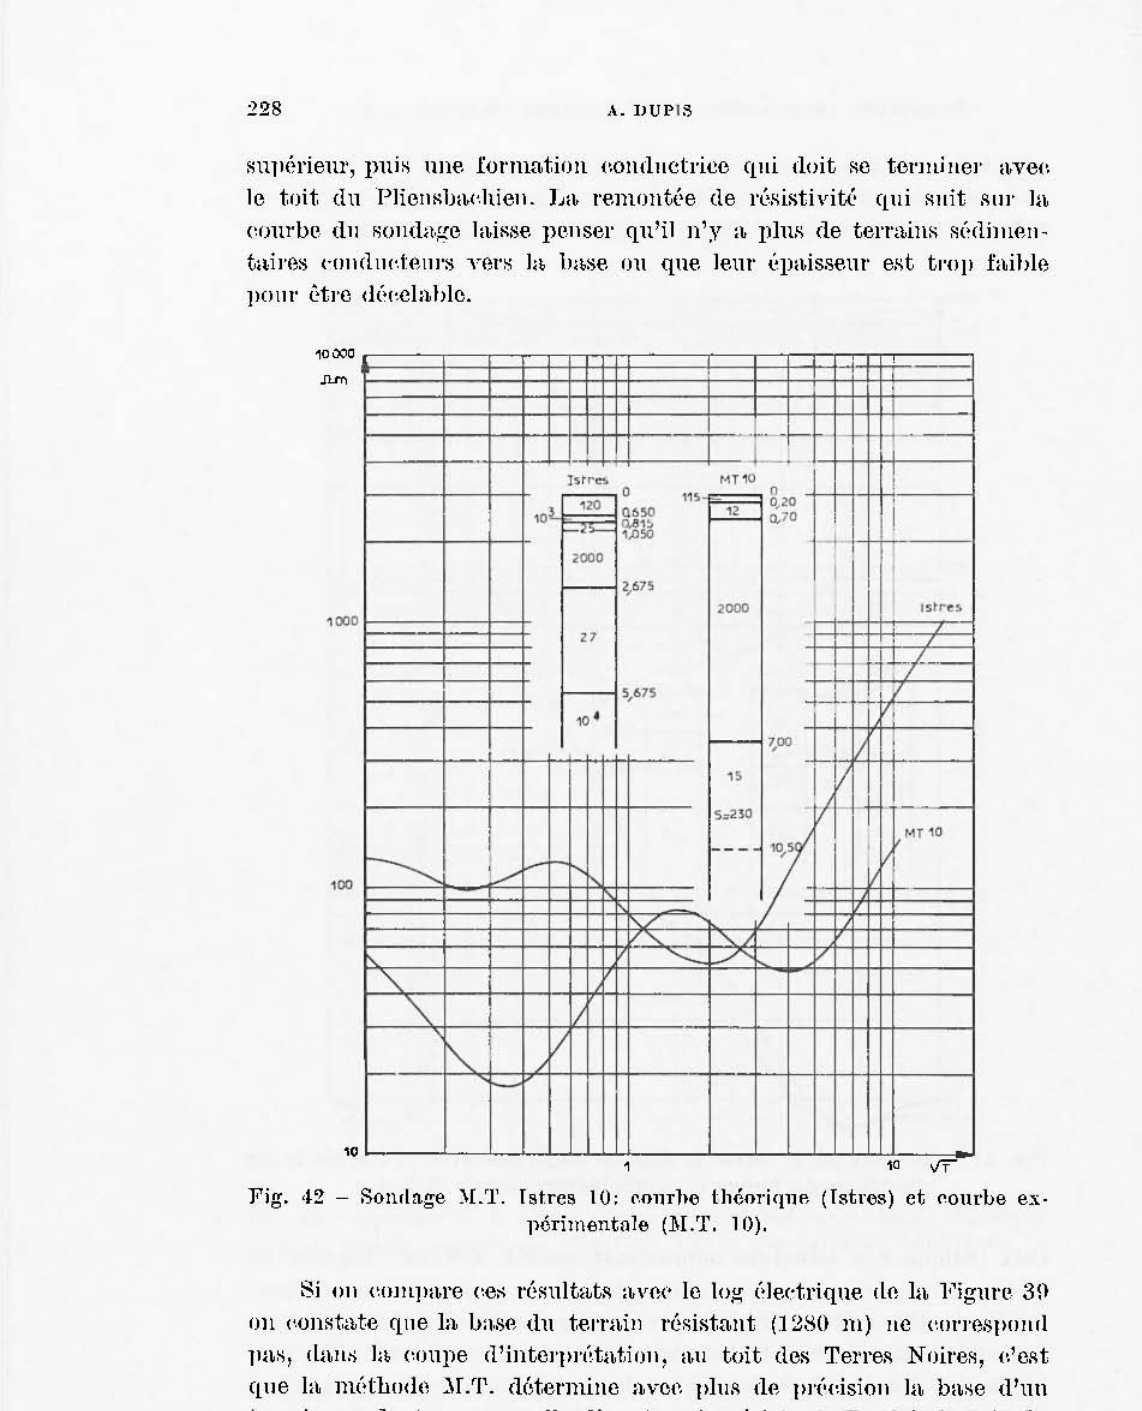
SOllrlage :\LT, Istres lO; r,f}lHhe lhénriqlHI (Istres) et rom'Le ex, périmentnle (M.T.